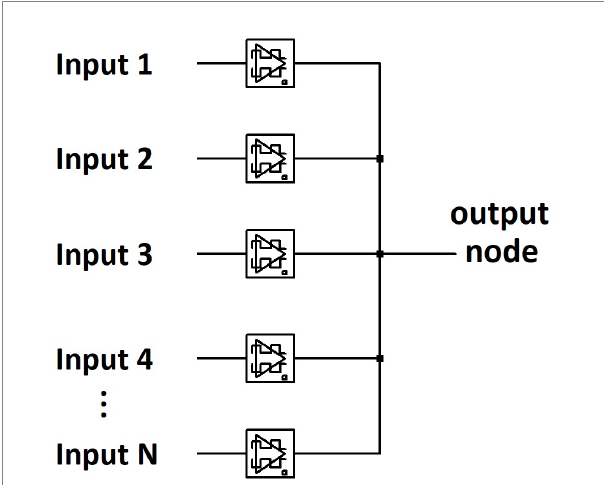
FIGURE 5 Abbreviated circuit schematic for a single layer memristive physical network capable of self-training via STDP.